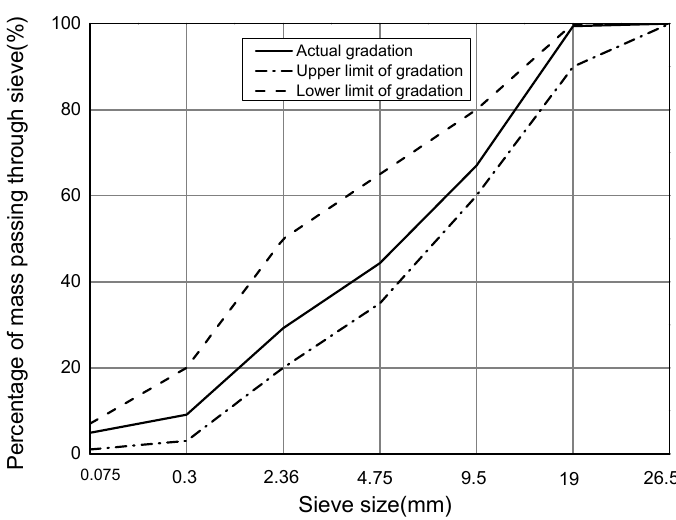
Figure 1. Gradation Curve of Emulsified Asphalt Cold Recycling Mixtures (65%RAP).